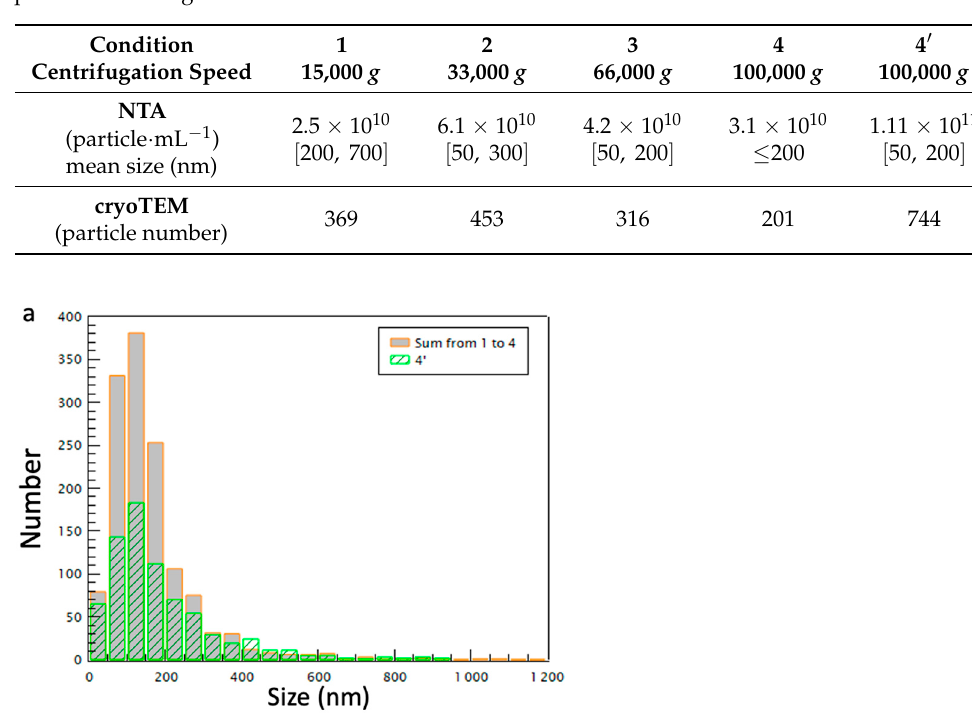
Table 1. Evaluation of the particle concentrations using NTA and Cryo-TEM techniques. The distribution in diameter is provided as a range of mean size. Each centrifugation condition was performed during 90 min.